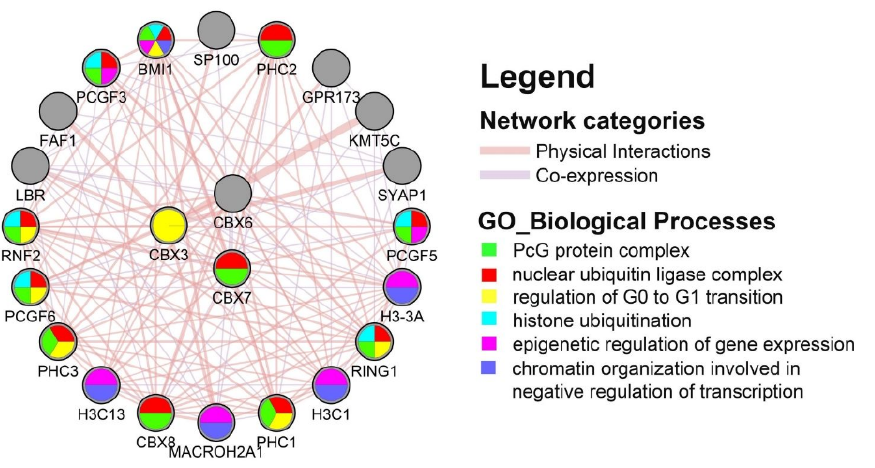
Figure 7. Protein–protein interaction network of CBX3, CBX6, and CBX7.